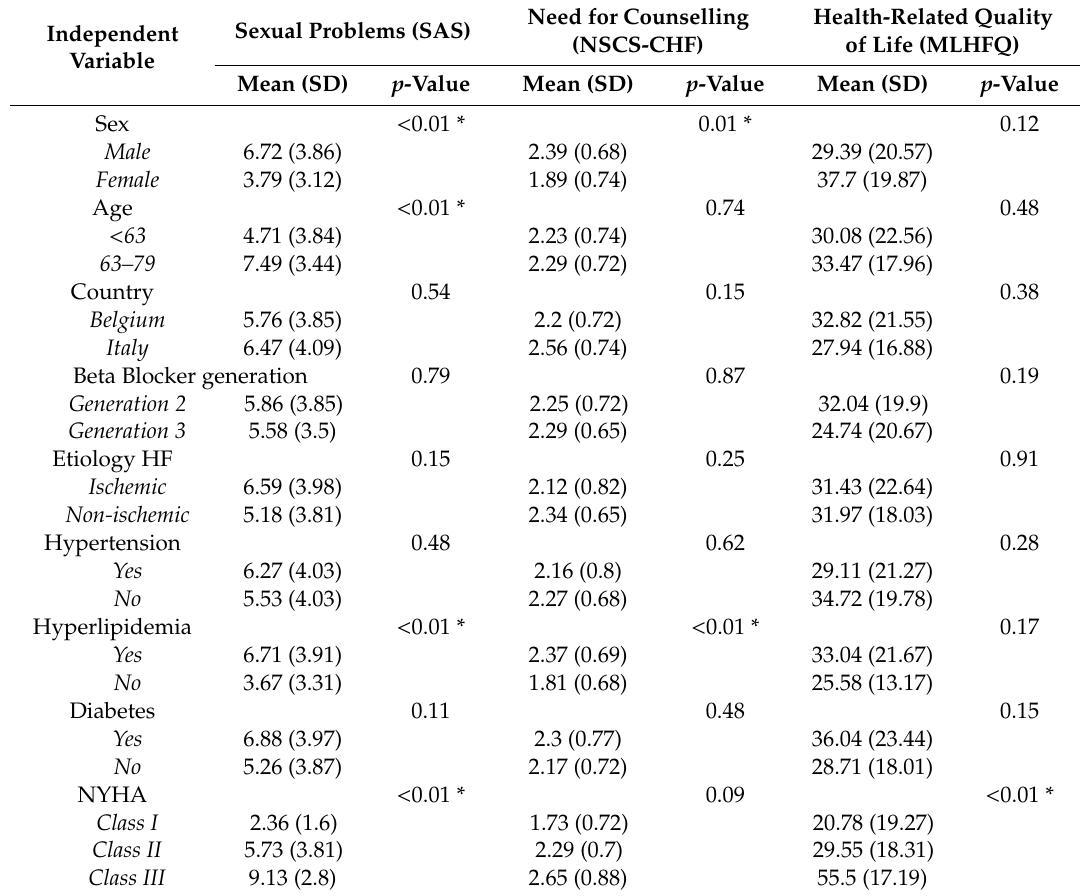
Table 2. Comparison between groups for the patient-reported